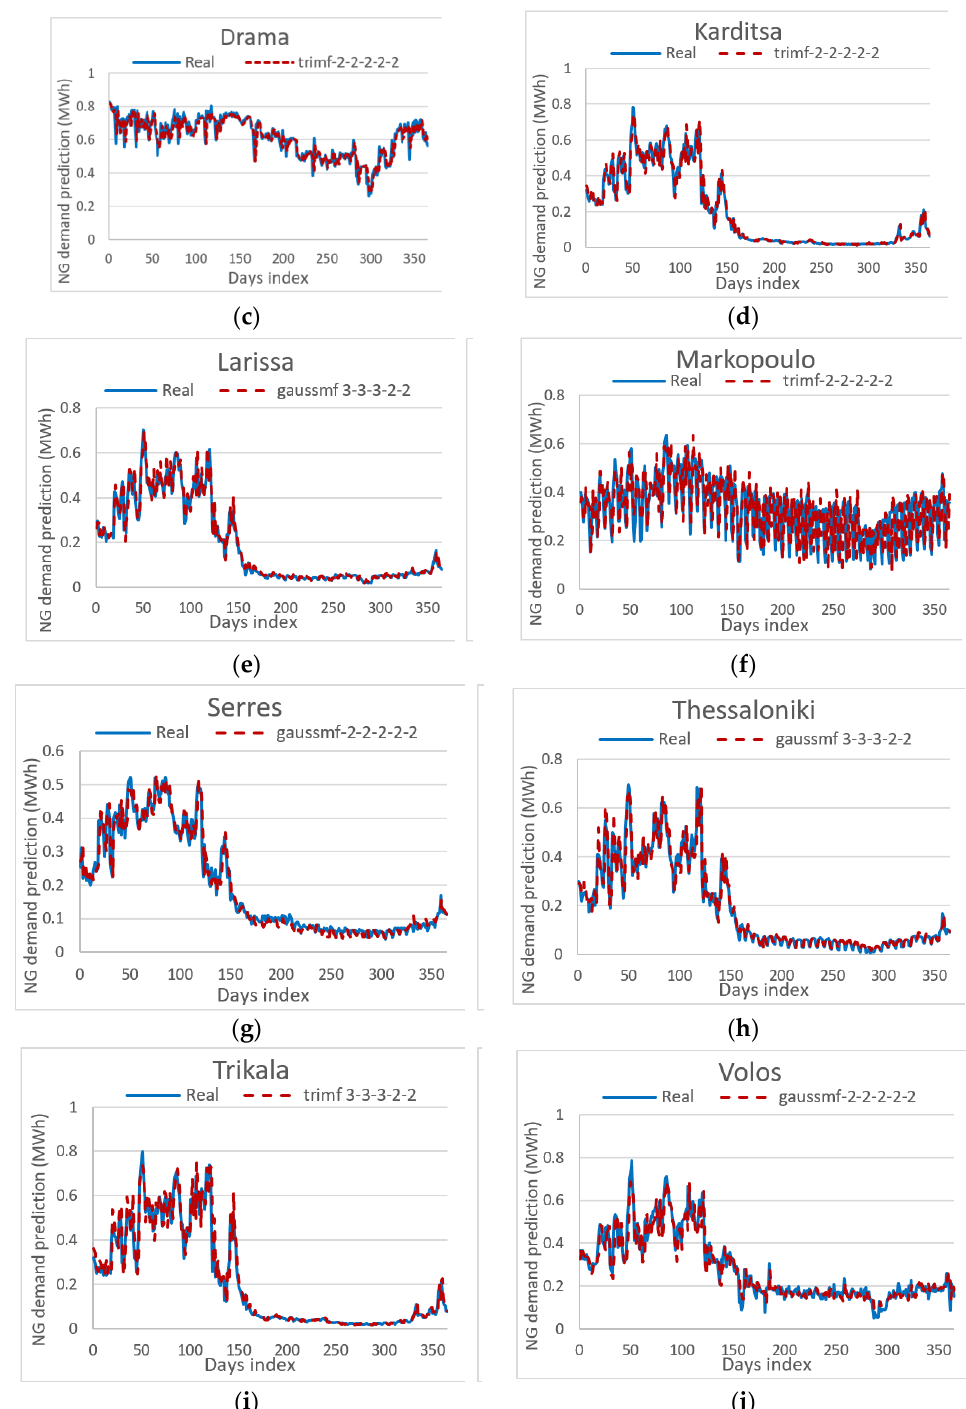
Figure 7. Forecasting results for three cities considering the best ANFIS method. ( a ) Testing Alexandroupoli, ( b ) testing Athens, ( c ) testing Drama, ( d ) testing Karditsa, ( e ) testing Larissa, ( f ) testing Markopoulo, ( g ) testing Serres, ( h ) testing Thessaloniki, ( i ) testing Trikala, ( j ) testing Volos.